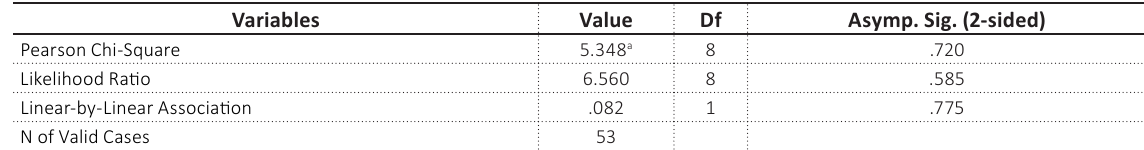
Table 2. Connection between the type of hospitals and the existence of persons responsible for clinical risk